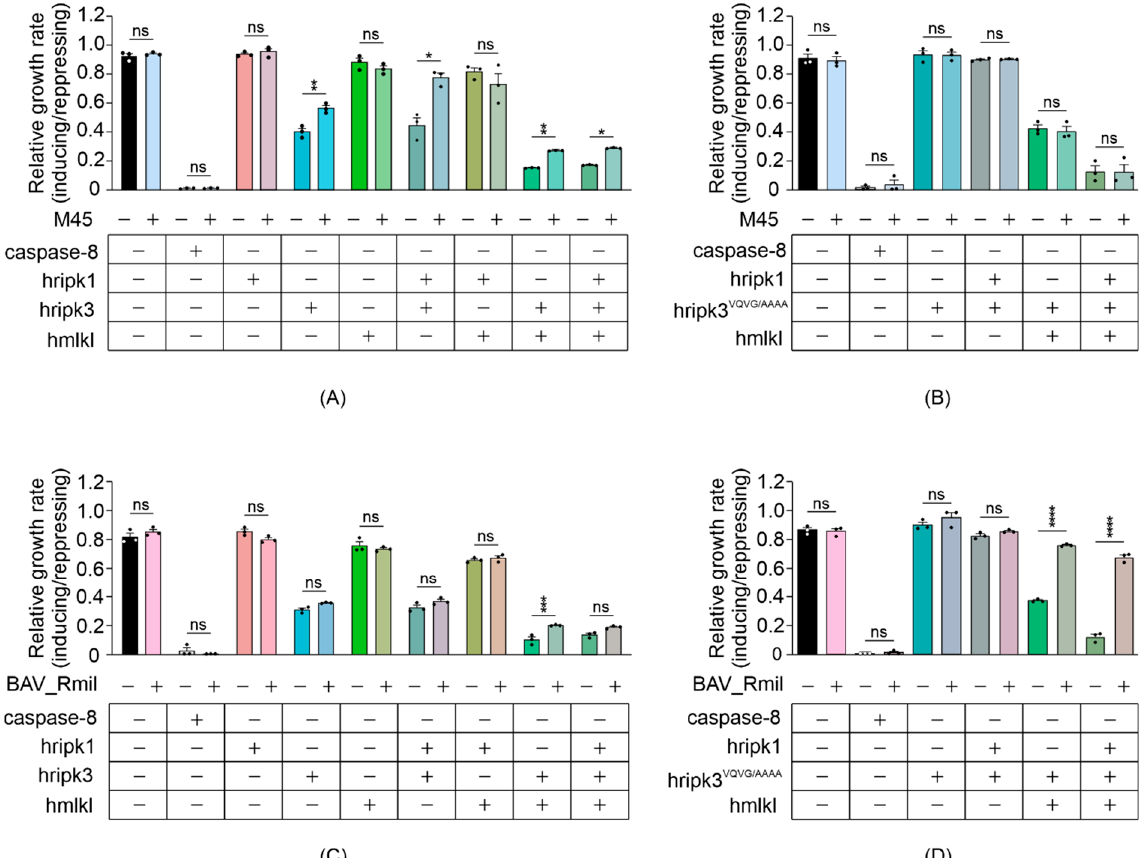
Figure 5. Viral necroptotic inhibitors reduce necrosome reconstitution-induced yeast lethality. ( A , B ) The effects of M45 on the growth of yeast in liquid media were analyzed by co-expressing necrosome effector(s) in yeast. Maximal growth rate of yeast bearing expression plasmids encoding human wild-type MLKL, RIPK1 and either RIPK3 ( A , C ), or RIPK3 VQVG/AAAA ( B , D ), with and without M45 ( A , B ) or BAV_Rmil ( C , D ) in liquid media, were analyzed by monitoring the relative maximal changes in absorbance between yeast cultures in inducing and repressing media. Differences in growth rates of yeast expressing necrosome effectors with or without the viral inhibitors were compared using ANOVAs with Sidak corrections. Data present mean ± SEM of three independent assays. *, p < 0.05; **, p < 0.01; ***, p < 0.001; ****, p < 0.0001 ns, not